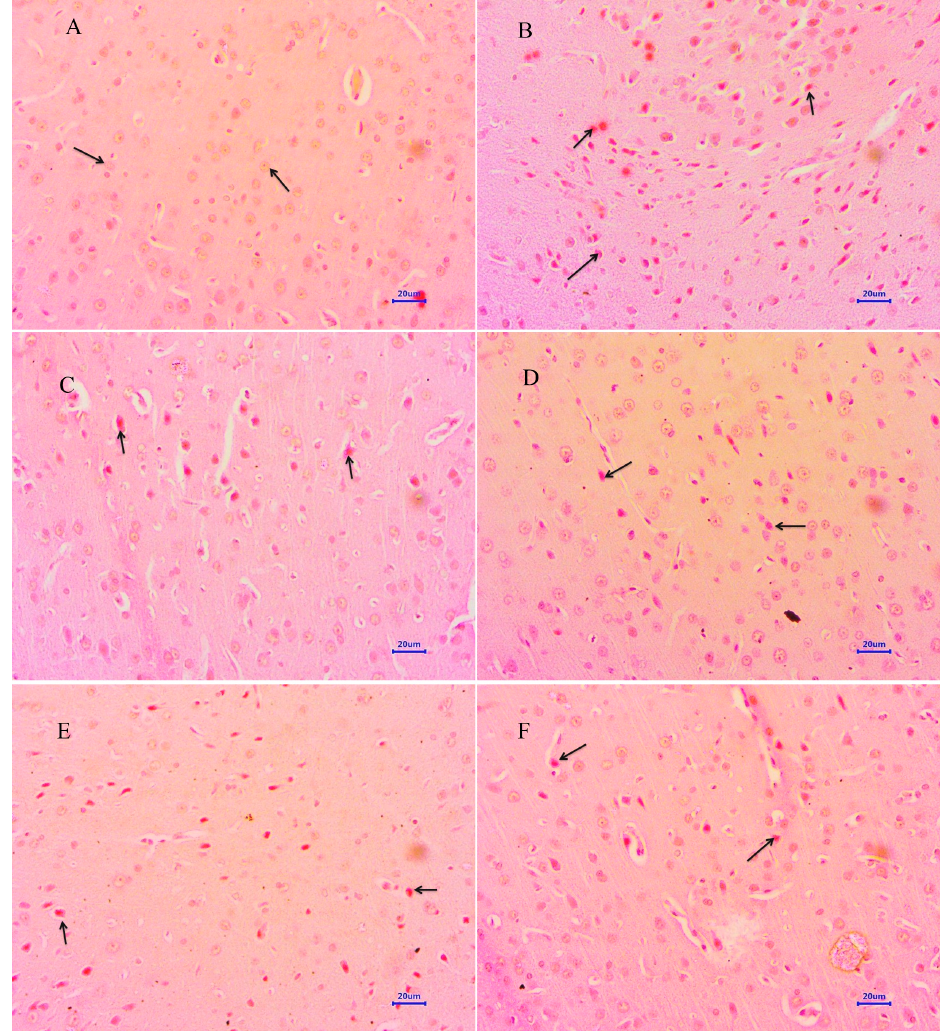
Figure 9. Effect of A β (1–42), baicalein and baicalein with memantine on Congo red staining in cortex (400 × ). ( A ) Normal control: displaying normal histology, normal neuronal cells in parietal cortex (arrow). ( B ) Disease control: displaying multifocal moderate to severe deposition of deposition of β -amyloid (arrow) in parietal cortex. ( C ) Memantine 20 mg/kg: displaying moderate deposition of β -amyloid (arrow) in parietal cortex. ( D ) Baicalein (10 mg/kg): displaying multifocal mild to moderate deposition of β -amyloid (arrow) in parietal cortex. ( E ) Memantine + Baicalein (20 + 5 mg/kg): displaying multifocal mild deposition of β -amyloid (arrow) in parietal cortex. ( F ) Memantine + Baicalein (20 + 10 mg/kg): displaying mild deposition of β -amyloid (arrow) in parietal cortex.